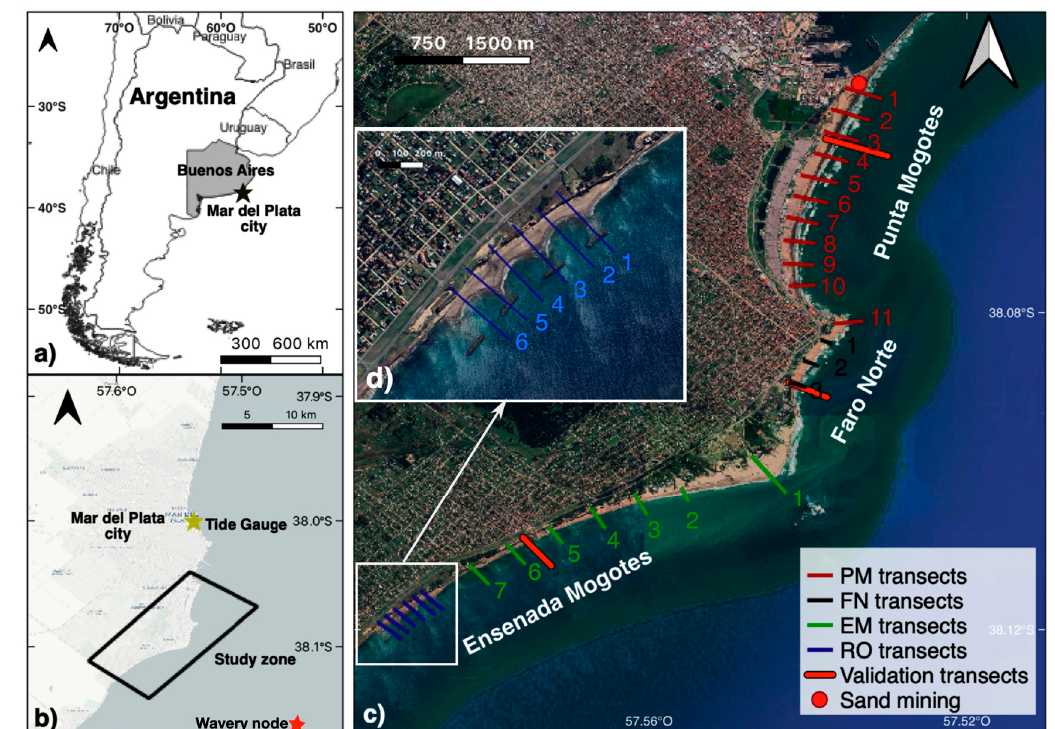
Figure 1. ( a ) Mar del Plata city, and its location at the east of the Buenos Aires Province in southern South America, is pointed out with a black star. ( b ) The study area, placed southward of Mar del Plata city (black polygon), the location of the tide gauge (yellow star), and global wave reanalysis node (red star). ( c ) Transects surveyed at PM (red), FN (green), EM (black), RO (blue), and transects used for CoastSat validation (orange). The sand mining area, next to Mar del Plata port, is depicted with a red circle. ( d ) Zoomed-in view of the breakwater sector (RO).